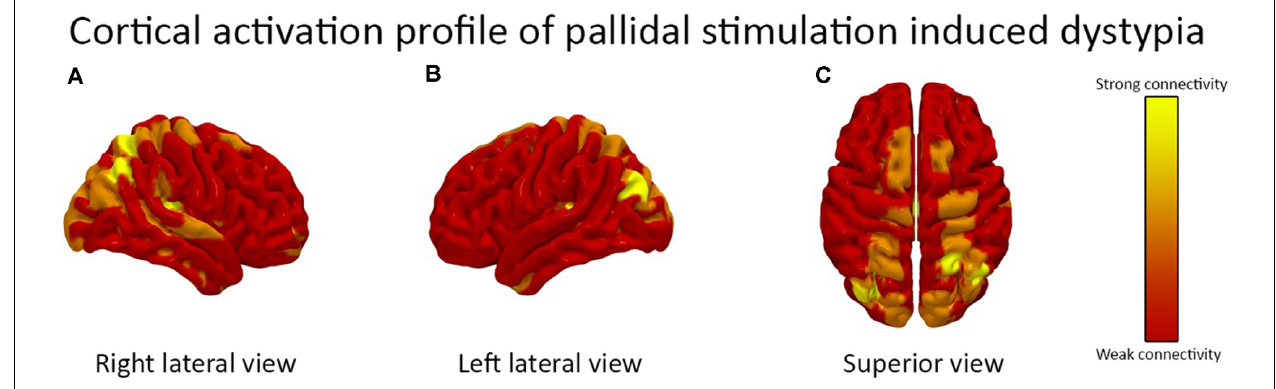
FIGURE 1 | The cortical activation pattern of bilateral globus pallidus internus (GPi) deep brain stimulation (DBS) is demonstrated. The (A) right lateral view (B) left lateral view and (C) superior view are shown. The activation pattern is based on the patient’s DBS device programming parameters. There was a strong activation of the right angular gyrus, left calcarine fissure, and left cuneus and moderate activation of bilateral supplemental motor areas and the superior parietal